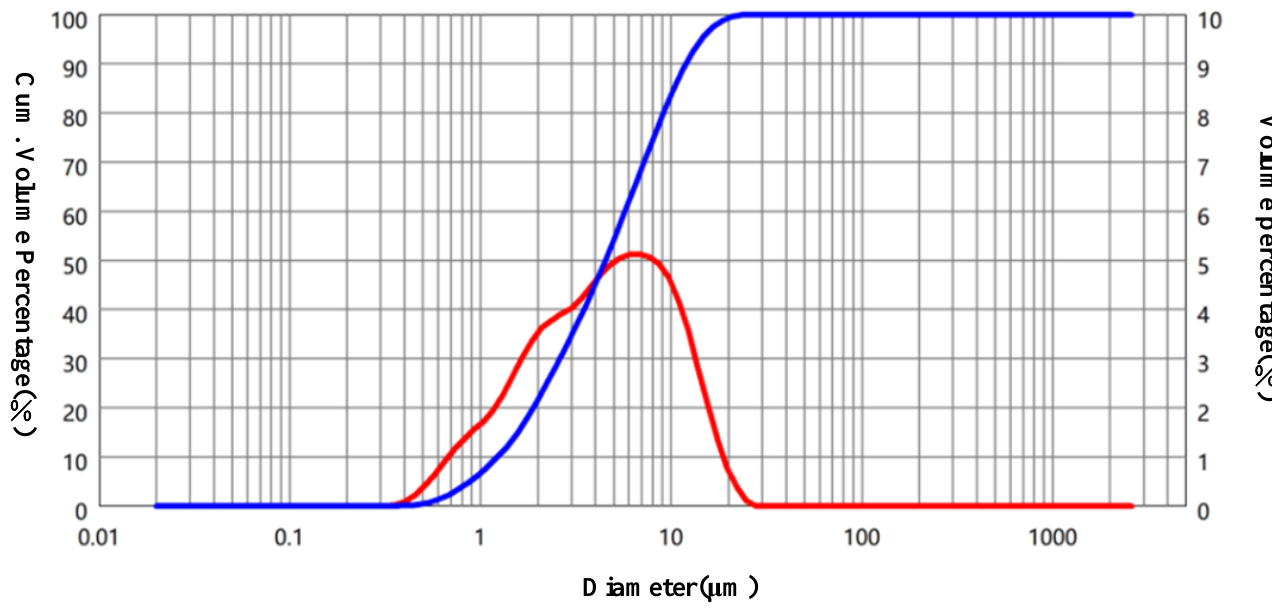
Figure 1. Particle size distributions of MP.